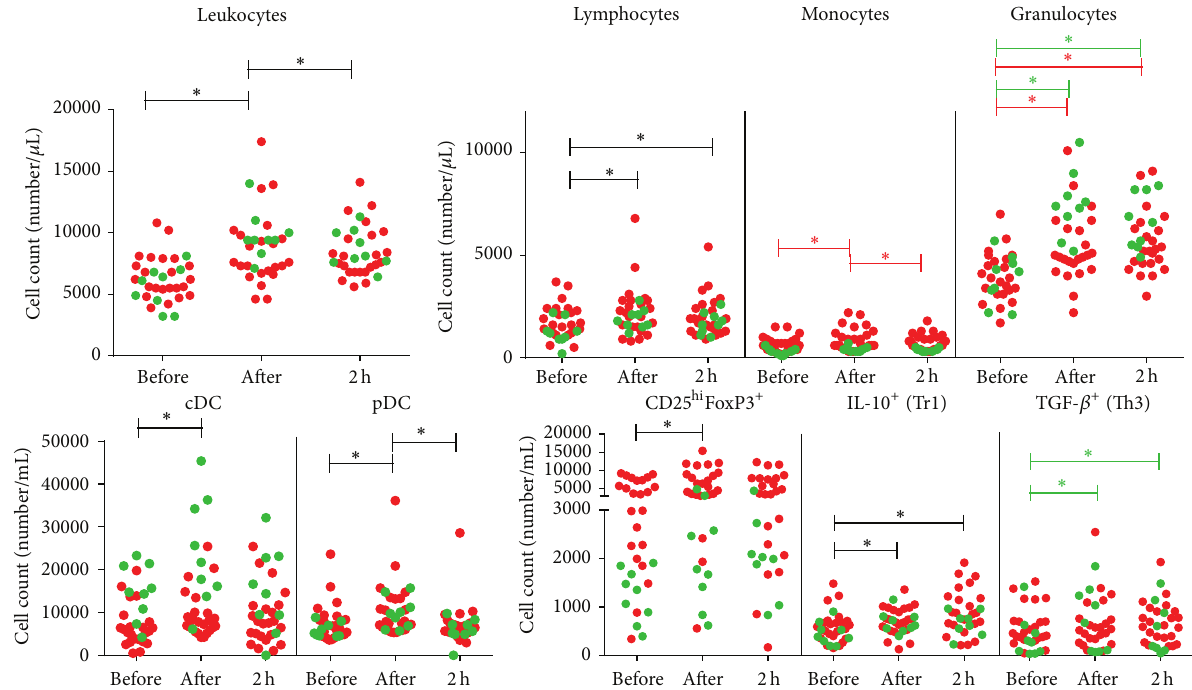
Figure 1: Leukocyte counts are increased upon physical exercise. Enumeration of the absolute number of immune cells was done by means of a double platform method using an automated cell counter and flow cytometry in healthy controls (green dots) and MS patients (red dots). Results are shown as mean absolute number ± SEM. Significance ( ∗ 𝑃 < 0.05 ) in the complete population of both patients and controls is annotated by black lines, while green and red lines annotate significance in controls and patients, respectively. Abbreviations used are as follows: MS: multiple sclerosis; cDC: conventional dendritic cells; pDC: plasmacytoid dendritic cells; Treg: regulatory T-cell; FoxP3: forkhead box P3; IL: interleukin; Tr1: type 1 regulatory T-cell; TGF: transforming growth factor; Th3: T helper type 3 cell; before: measurement